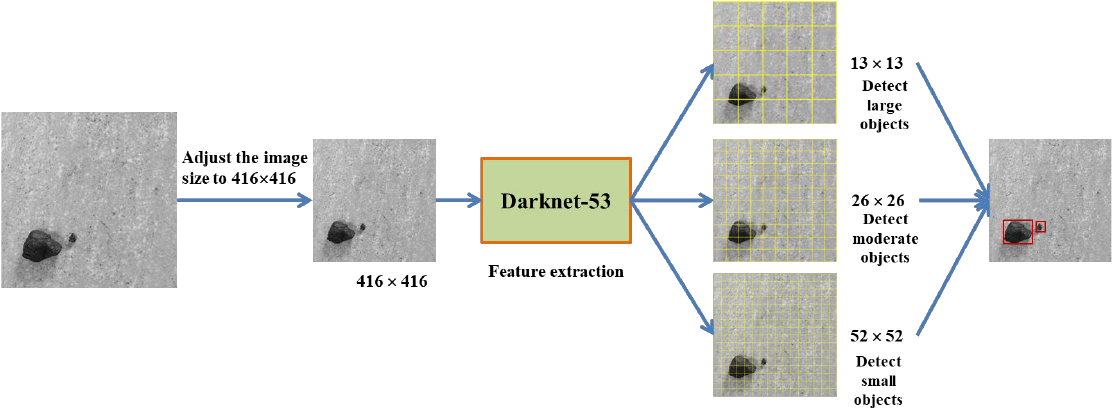
Figure 5. Principle of YOLOv3.